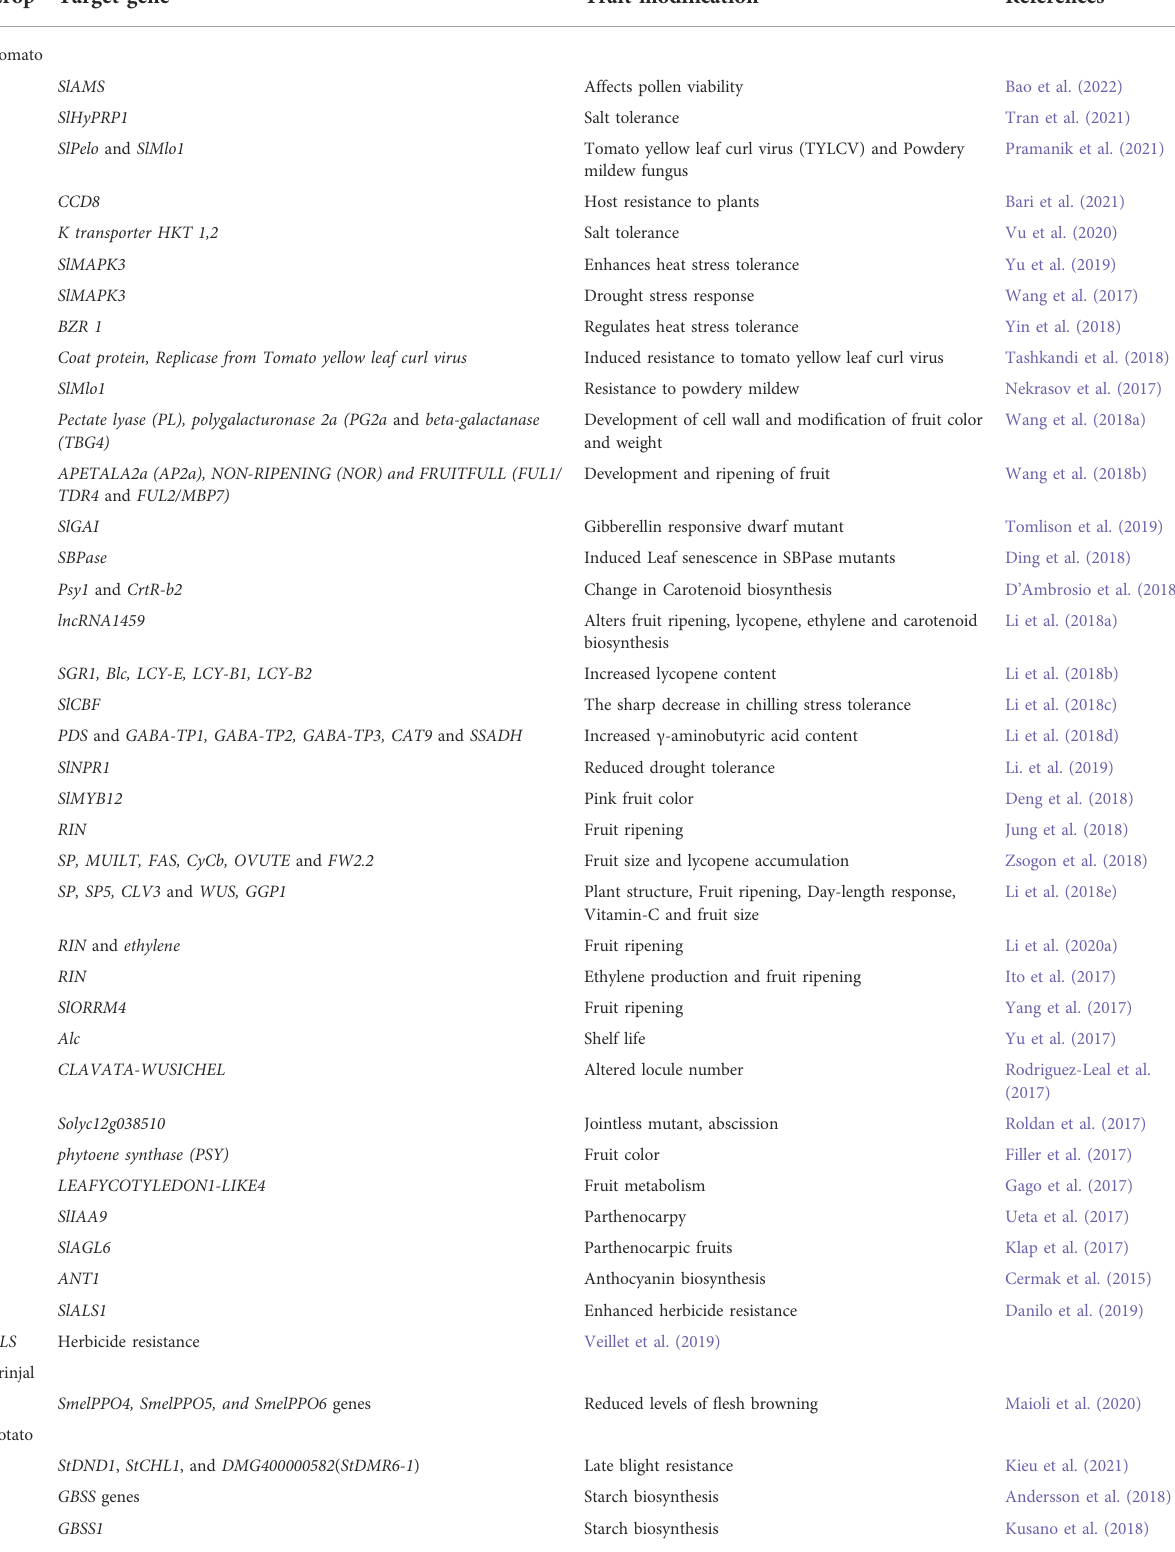
TABLE 3 List of traits modi fi ed by Crispr/Cas in vegetable